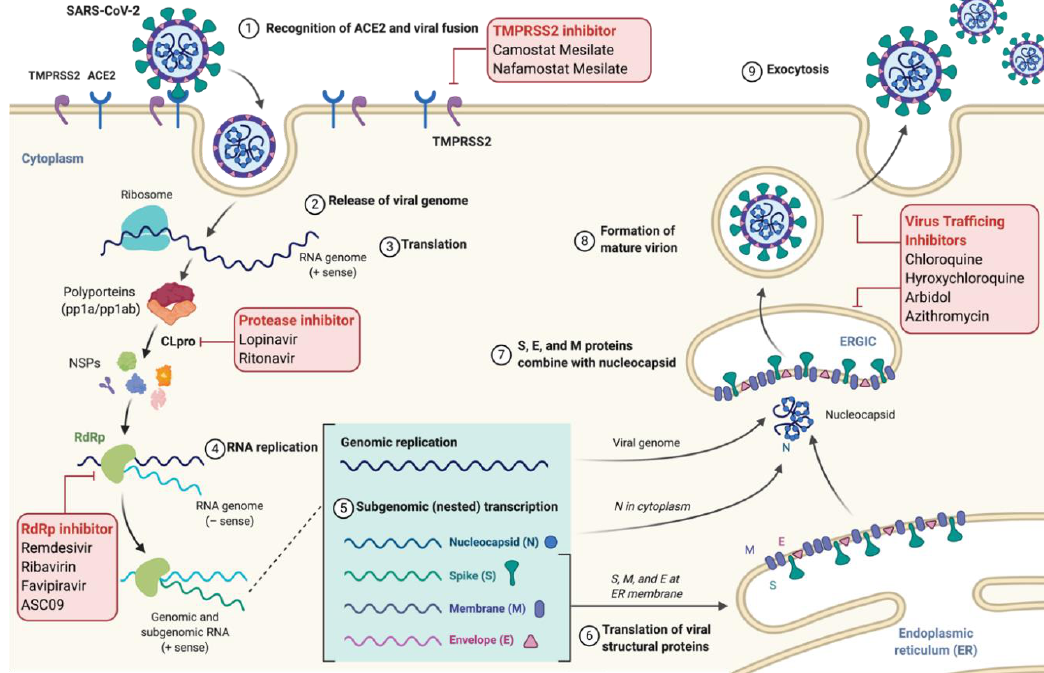
Figure 3. Graphical abstract depicting the SARS-CoV-2 replication cycle and site of action for widely studied drugs against COVID-19. (1) The virus enters the host cell by recognizing the ACE2 receptor via spike glycoprotein which induces membrane fusion, resulting in (2) release of viral genome in the cytoplasm. (3) The viral RNA undergoes translation to form polyproteins, which are then cleaved by the viral protease enzyme (CLpro) to form nonstructural proteins like RdRp for replication of viral RNA. Positive sense of viral RNA then undergoes translation to form structural proteins (N, S, M, and E) where S, M, and E are processed in ER (6), while N protein is processed in the cytoplasm where it assembles with a viral RNA replicon. All components are then combined inside the ER-golgi intercompartment (ERGIC) (7), from which virions are released inside the vesicles (8) and secreted outside the cell via exocytosis (9). ACE2: Angiotensin Converting Enzyme 2; TMPRSS2: Type 2 Transmembrane Serine Protease; NSPs: Non-structural proteins; RdRp: RNA dependent RNA polymerase; and CLPro: Coronavirus Protease.